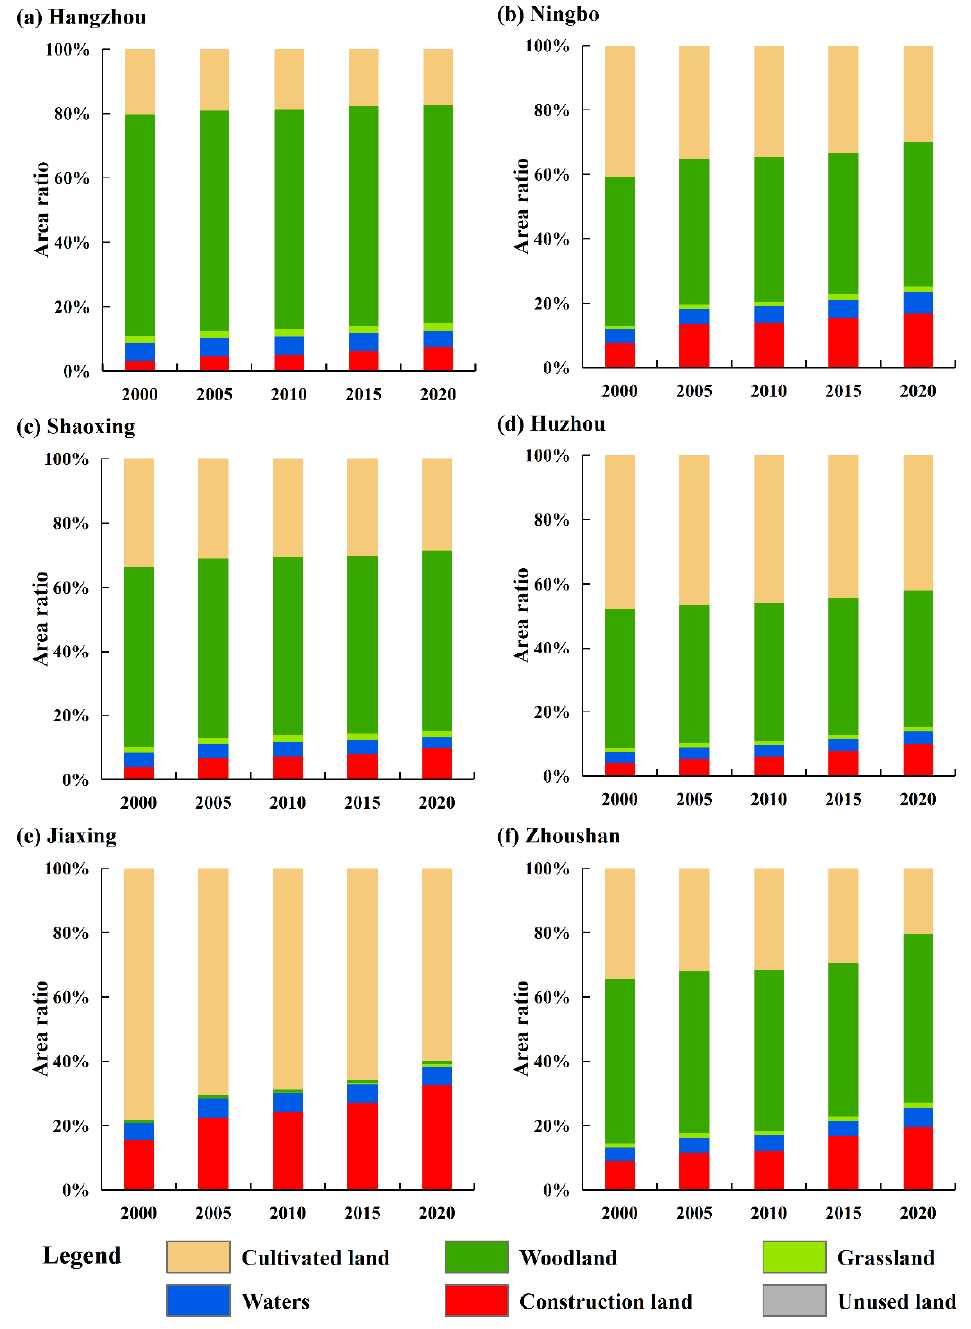
Figure 5. Area proportion of different land-use types in HBUA from 2000 to 2020.